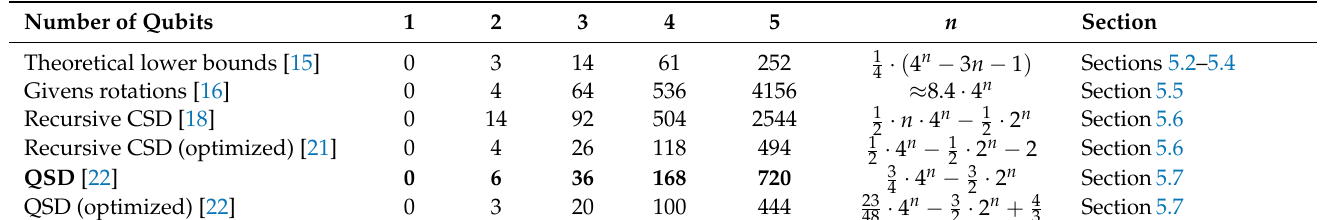
Table 1. CNOT counts for different implementations of unitary decomposition for one through five-qubit gates, as well as an n -qubit unitary gate.